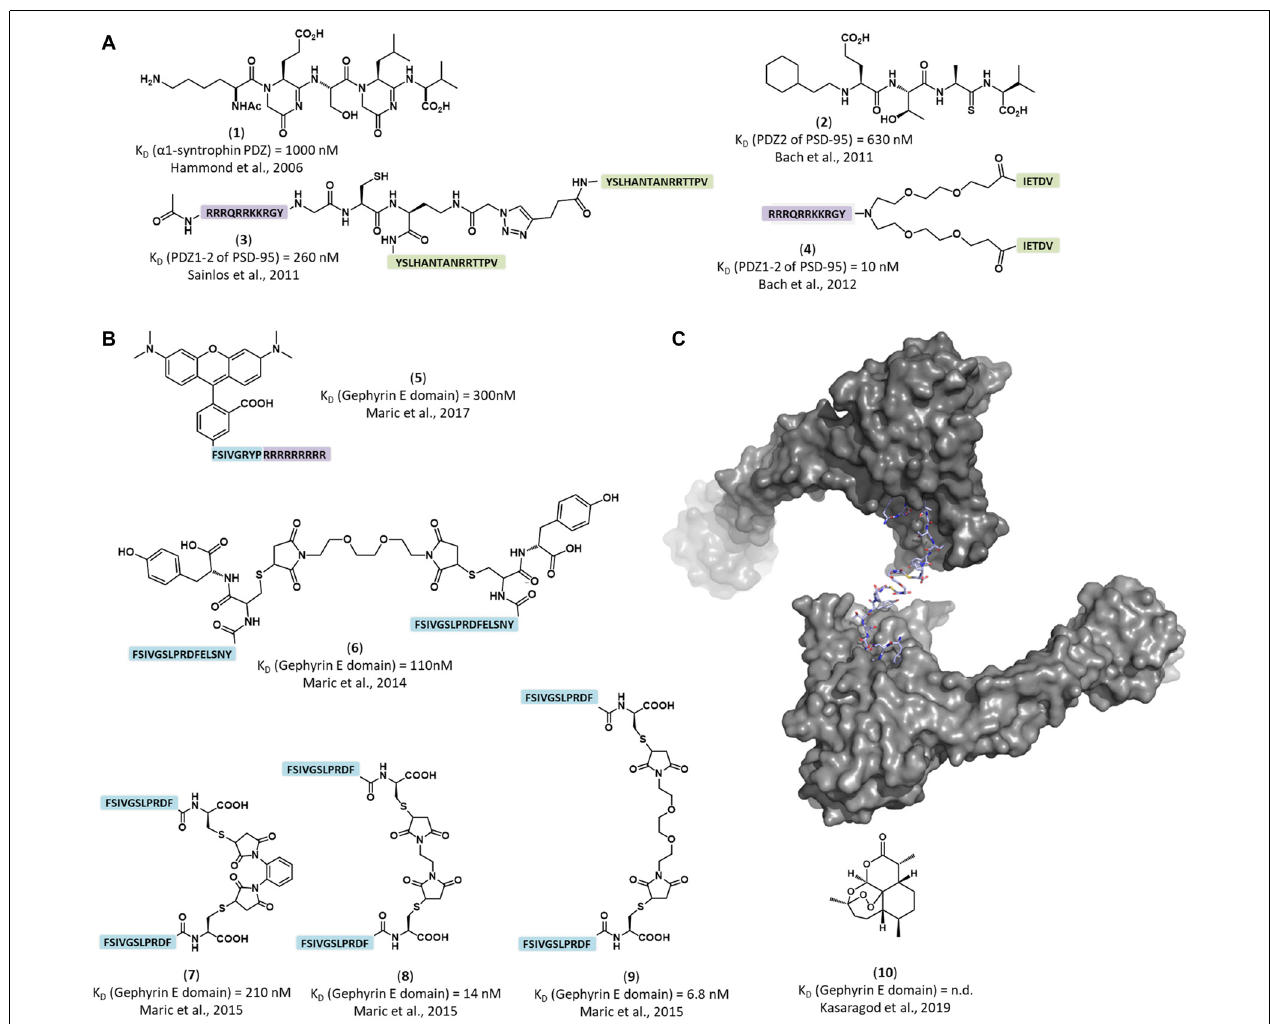
FIGURE 2 | Structure of representative inhibitors and labels of the inhibitory post-synaptic scaffold gephyrin and the excitatory post-synaptic scaffold PSD-95. (A) Peptidomimetic and dimeric PSD-95/Discs-large/ZO-1 (PDZ) domain binders. PSD-95 binding peptides (green) were dimerized and combined with cell-penetrating moieties (violet). (1) Peptidomimetic ligand for a α -1 syntrophin PDZ domain (Hammond et al., 2006). (2) Peptidomimetic inhibitor of the PSD-95 PDZ2 domain (Bach et al., 2011) (3) Dimeric inhibitor of PSD-95 PDZ domains, showed strong inhibition of AMPA receptor synaptic currents (Sainlos et al., 2011). (4) Dimeric inhibitor of PSD-95 PDZ domains, showed neuroprotective properties in mice with cerebral ischemia (Bach et al., 2012). (B) Engineered peptide-based gephyrin inhibitors and fluorescent labels. (5) Peptide-based fluorescent gephyrin label (Maric et al., 2017). Tamra dye was directly conjugated to gephyrin binding sequence (blue) combined with cell penetrating peptide (in purple). (6–9) Nanomolar affinity dimerized gephyrin peptide binders (blue; Maric et al., 2015). (10) The small molecule inhibitor artemisinin competes with the universal engineered peptide-based molecules for receptor binding pocket (Kasaragod et al., 2019). (C) Representative crystal structure of a peptide dimer engaging with a gephyrin E domain dimer (PDB-ID 4U90; Maric et al.,